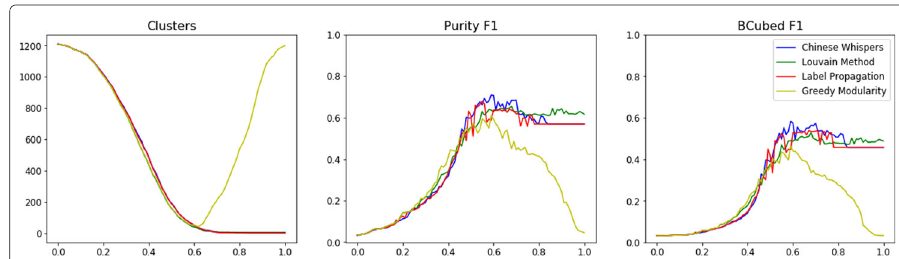
Fig. 9 Semantic role induction results achieved using different community detection algorithms. The horizontal axis refers to the neighboring threshold used to create the edges